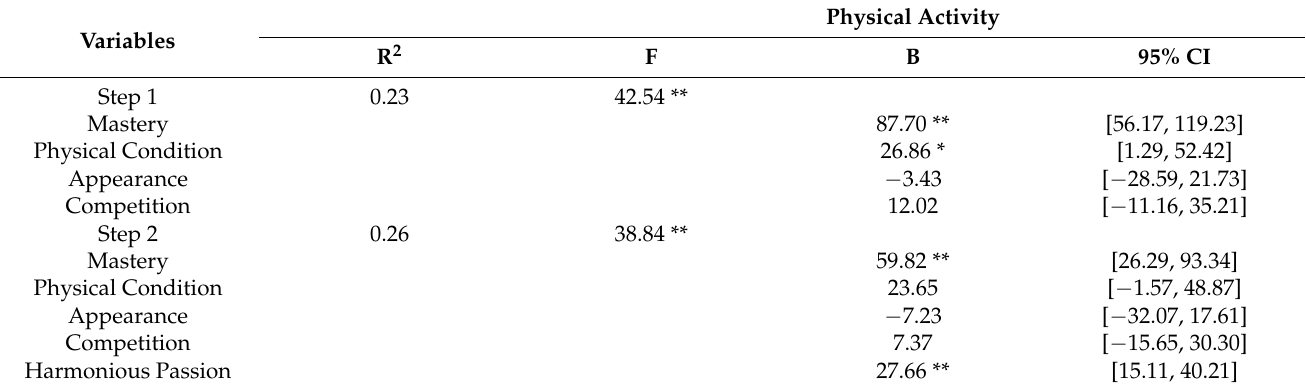
Table 2. Multiple hierarchical regression analysis for measuring the significance of PALMS, harmo- nious passion and obsessive passion as predictors of overall PA ( N =